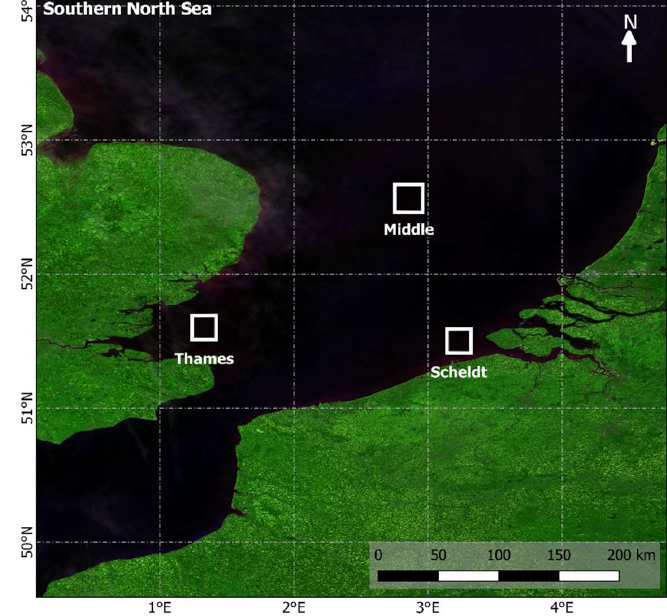
Figure 5. Demarcation of three subsites in the Southern North Sea used for time-series intercomparison: near the outlet of the Thames River, near the outlet of the Scheldt River and in the Middle of the North Sea.